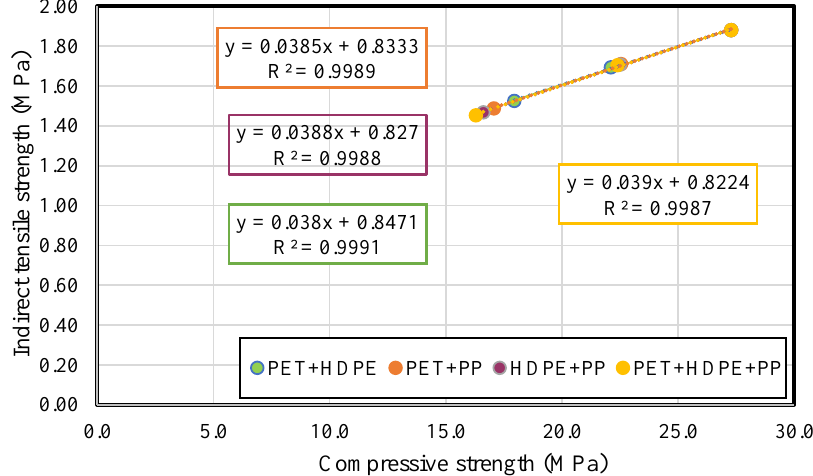
Figure 11. The relationship between the compressive and the predicted indirect tensile strengths.